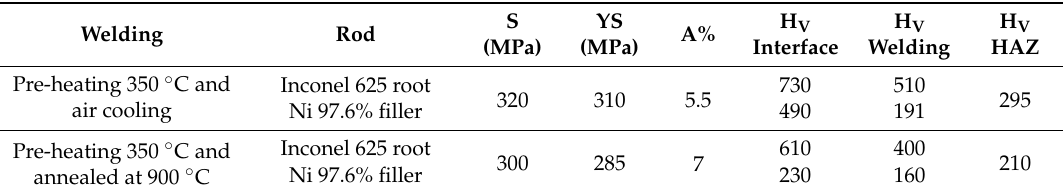
Table 4. Mechanical properties of the ductile iron